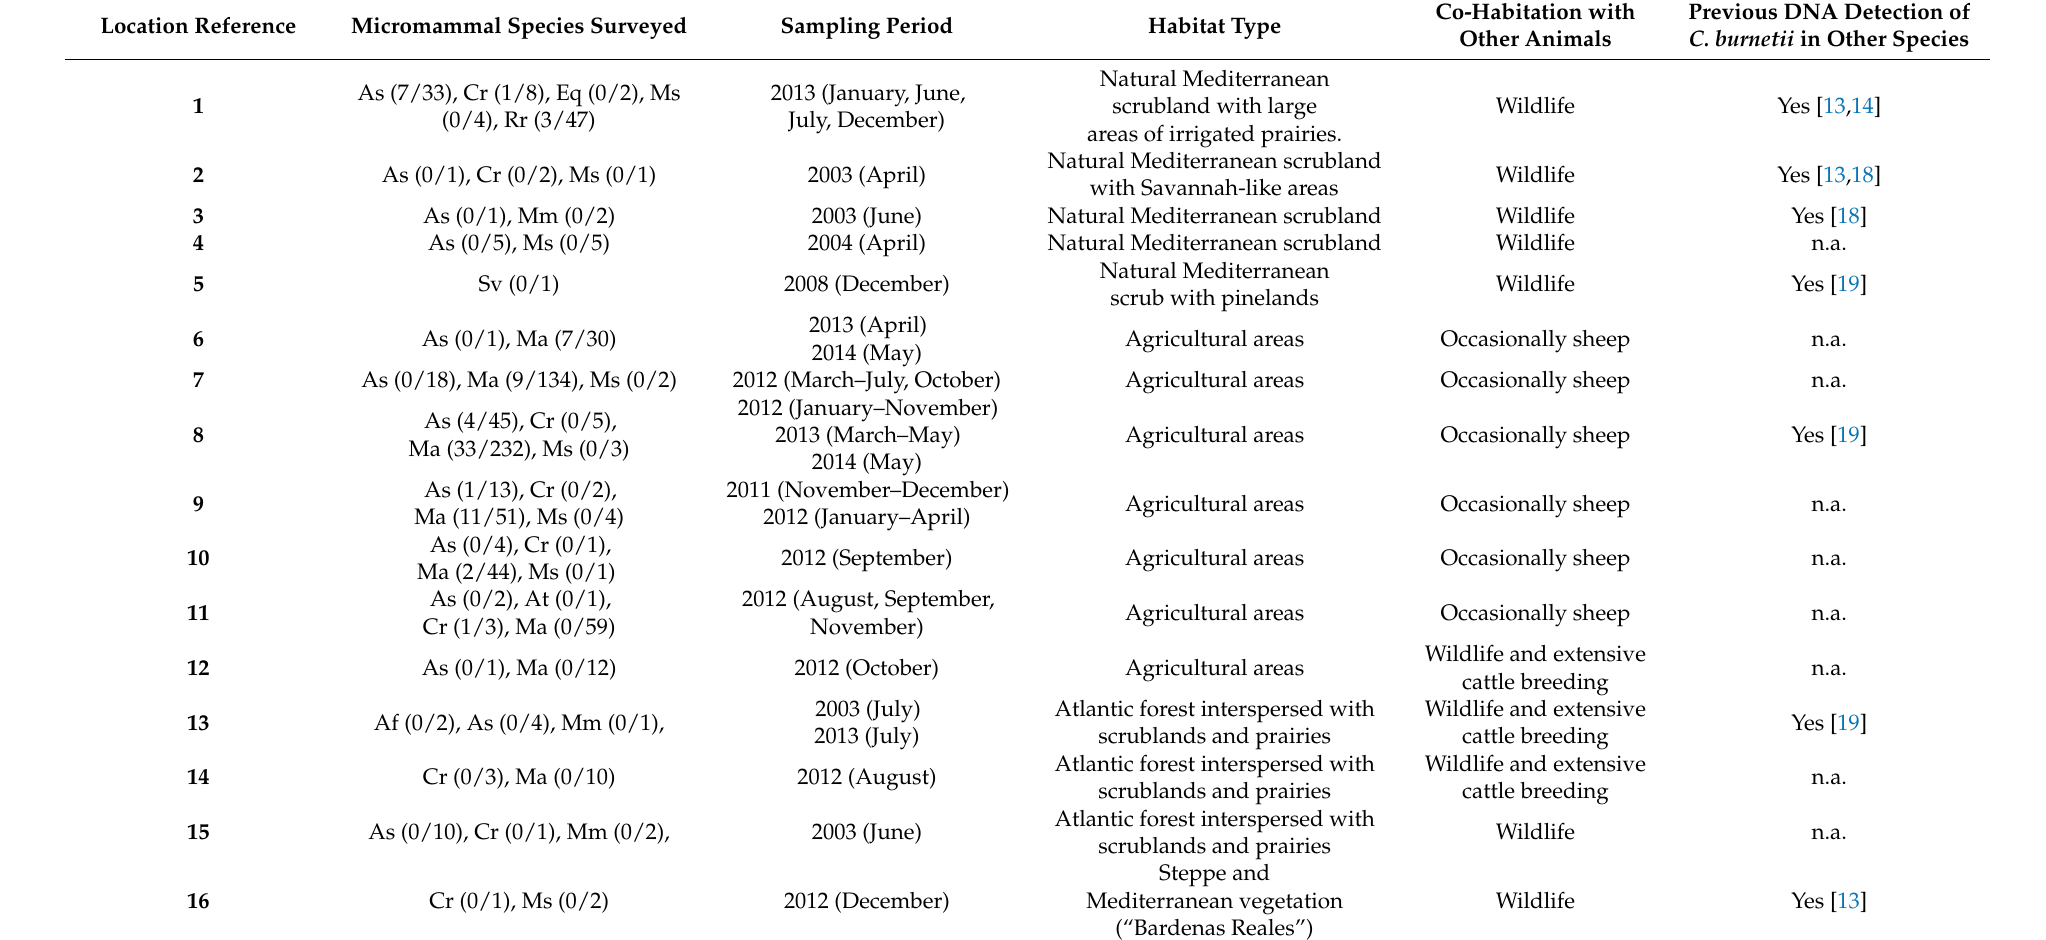
Table 1. Species of micromammals surveyed per study location as shown in Figure 1: Apodemus flavicollis (Af), Apodemus sylvaticus (Ap), Arvicola terrestris (At), Crocidura russula (Cr), Eliomys quercinus (Eq), Microtus arvalis (Ma), Mus musculus (Mm), Mus spretus (Ms), Rattus rattus (Rr), Sciurus vulgaris (Sv). The PCR-positive (p) vs. the total number (n) of samples per micromammal species (p/n) and location is shown. In addition, the year(s) and month(s) of sampling, the habitat type, the presence of other co-existing animal species as well as the existence of evidence of previous detection of C. burnetii in non-micromammal species in the location are included. n.a. = data not